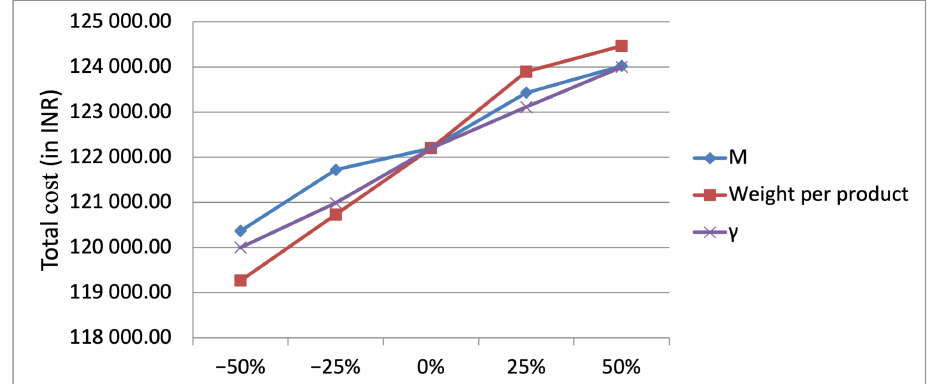
Figure 4. Effect of changes in values of parameters on total